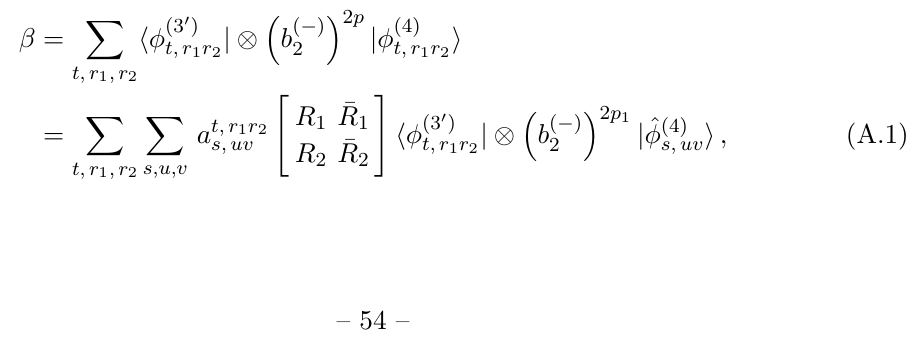
Ψ . The S 2 boundaries labeled j 3 (cid:30) |